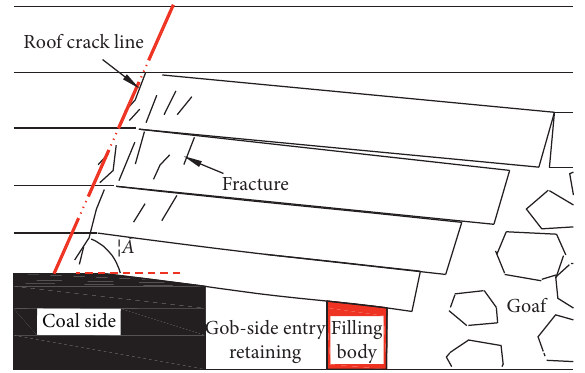
Figure 7: Fracture development area of the roof above the solid coal